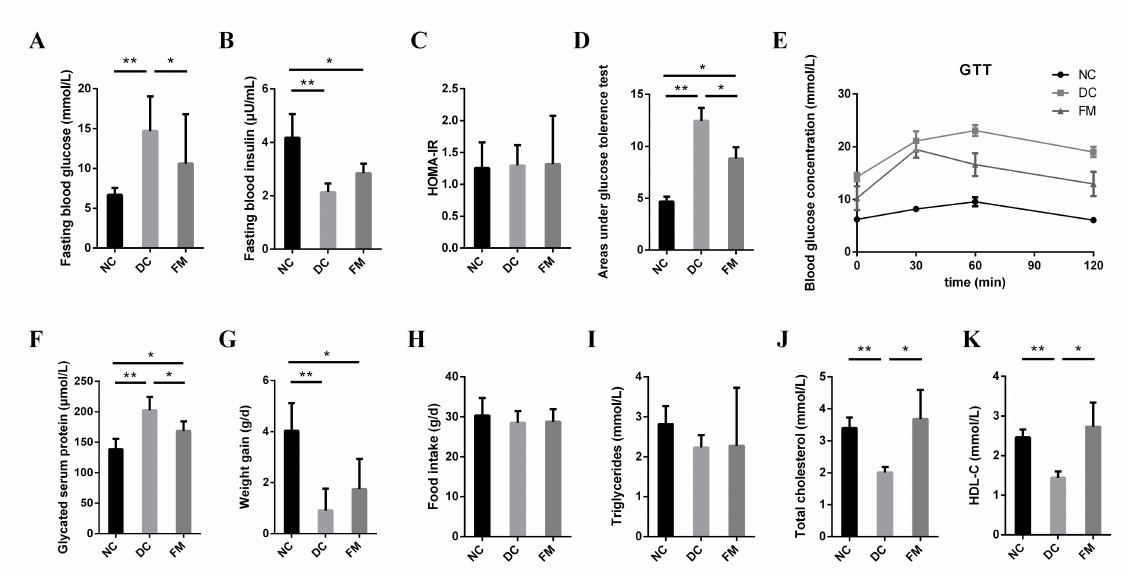
Figure 1. Effect of foxtail millet supplementation on glucose metabolism ( A – F ), weight gain ( G ), food intake ( H ), and lipid metabolism ( I – K ) in HFD/STZ-induced diabetic rats. Data were represented as mean ± SD. NC, normal control group ( n = 8); DC, diabetic control group ( n = 8); FM, foxtail millet supplementation group ( n = 8); GTT, glucose tolerance tests; HDL-C, high-density lipoprotein cholesterol. Differences between groups were compared using one-way ANOVA with Tukey’s multiple comparison post hoc test, * p < 0.05, ** p <